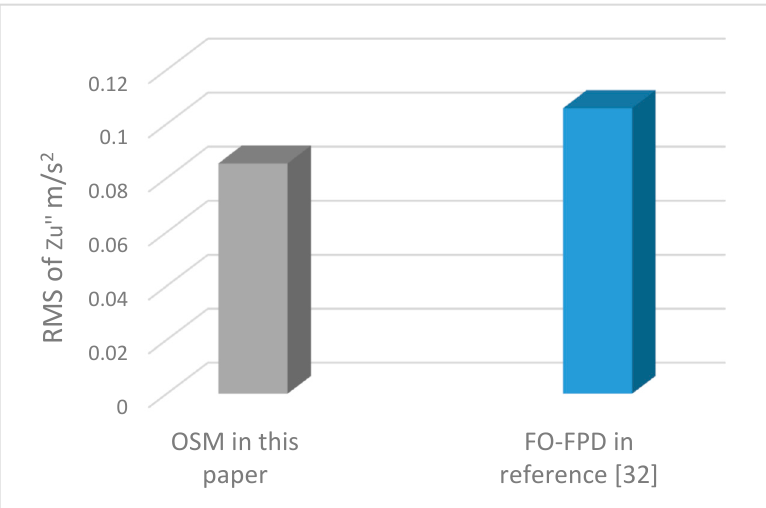
Figure 13. Comparison of optimum results of two controllers.